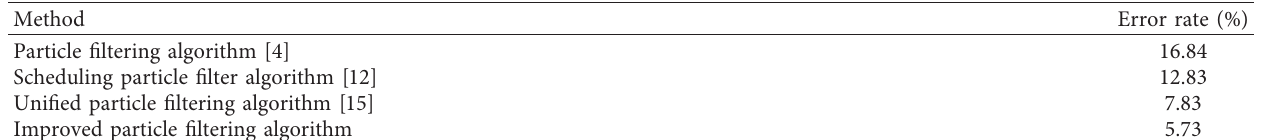
Figure 6: Root mean square error of parameter identification value and mean value of relative error. (a) Root mean square error. (b) Relative Table 2: Different English pronunciation rationality optimization recognition error rate.